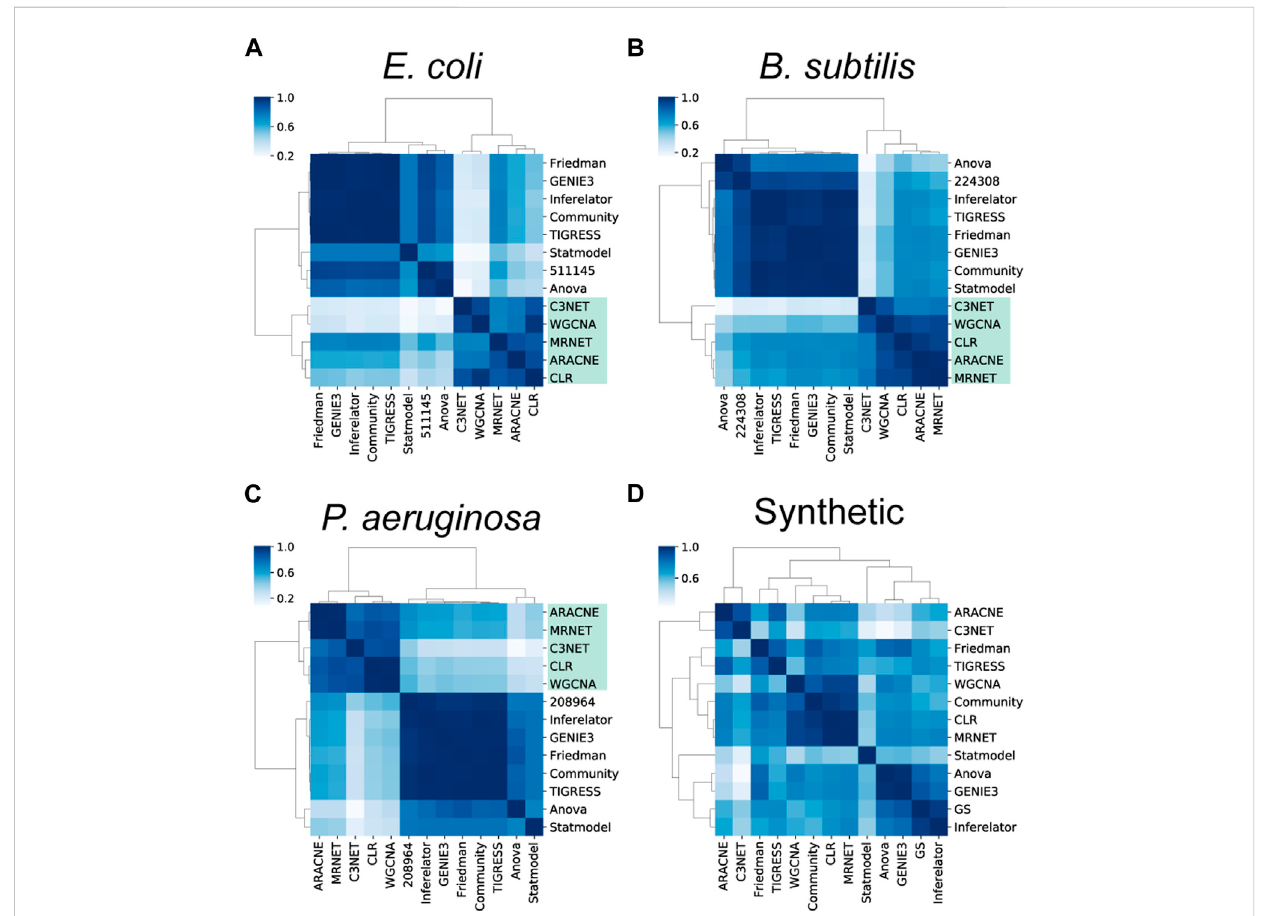
FIGURE 5 Assessment of the structural properties. Clustering of the global structural properties suggests there is a clear structural difference between causal (CAUS) and non-causal (COEX) networks. In contrast to the inferences with biological data (A – C) , most networks inferred from synthetic data (D) are more similar to each